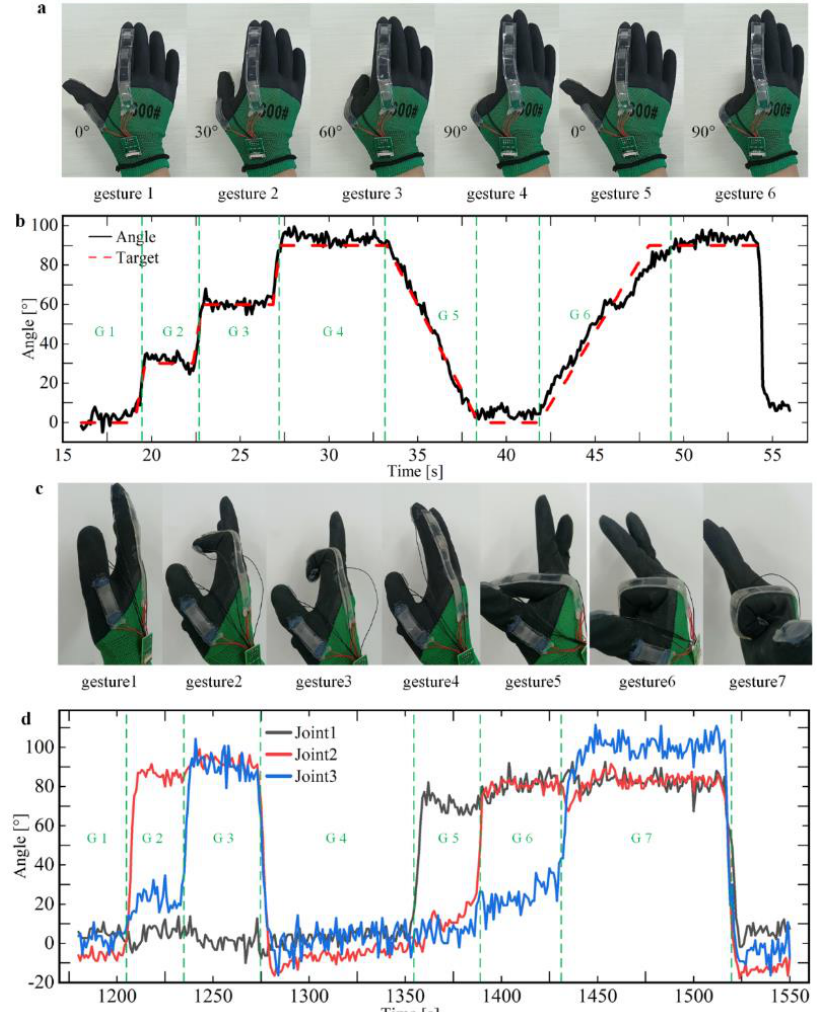
Figure 5. Testing and analysis of the bending performance of the sensing glove. The performance of the sensing glove refers to the ability to accurately detect the bending angle of the finger joint after placing the sensor on the glove and fitting it with the finger joint. ( a ) The gesture of bending one joint of the thumb, where the bending angle traverses 0 − 90 ◦ . ( b ) Detection of the bending angle of different gestures and test the degree of similarity between the measured angle and the target angle. ( c ) The gesture of bending the knuckles of the index and middle fingers at an angle from 0 ◦ to 90 ◦ . ( d ) Detection of the bending angle of multiple joints of the index finger. Figure S7a shows the layout of joint sensors on the index finger, and three sensors correspond to three joints. We performed a similar experiment on the thumb, measuring the angle detection ability of the sensor on the index finger. Based on the theory above, there is a certain linear relationship between resistance value and bending angle (Figure 3c,e), so different gestures change the resistance of the sensor. The starting angle θ a = 0 ◦ and the ending angle θ b = 90 ◦ of the sensor is set, and the calibration is completed by two actions of expanding the palm and clenching the fist, and the starting point calibration resistance R a and the ending point calibration resistance R b of each sensor are saved. After the calculation of the program, the fitting slope k of each sensor is obtained, and the current real − time joint angle is calculated according to Equation (14) and the resistance